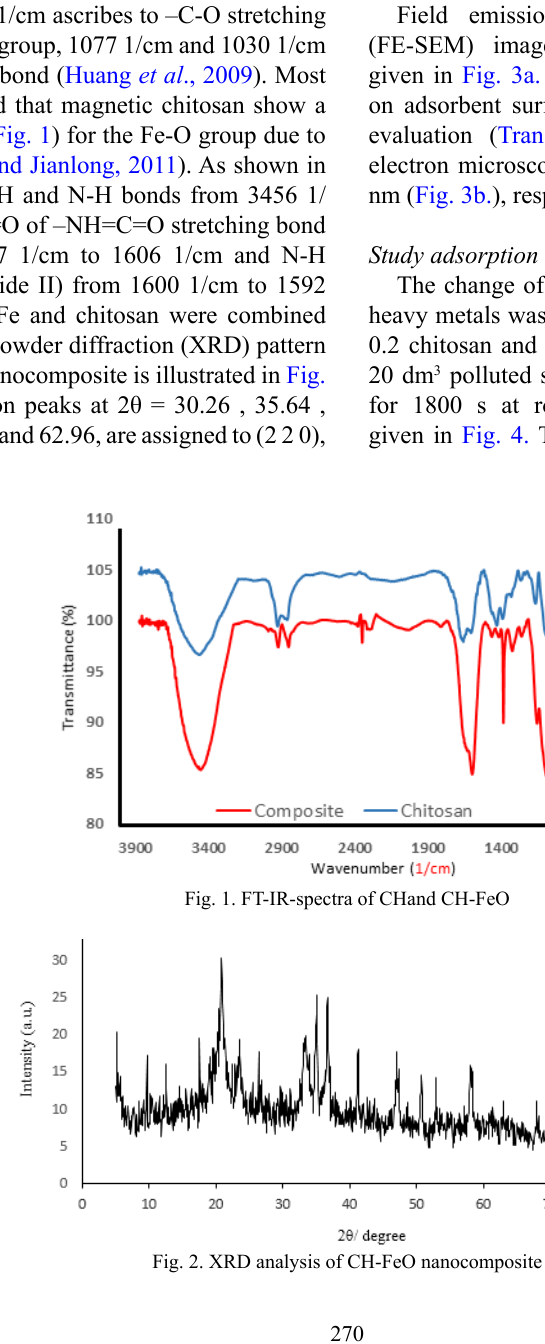
Fig. 1. FT-IR-spectra of CHand CH-FeO